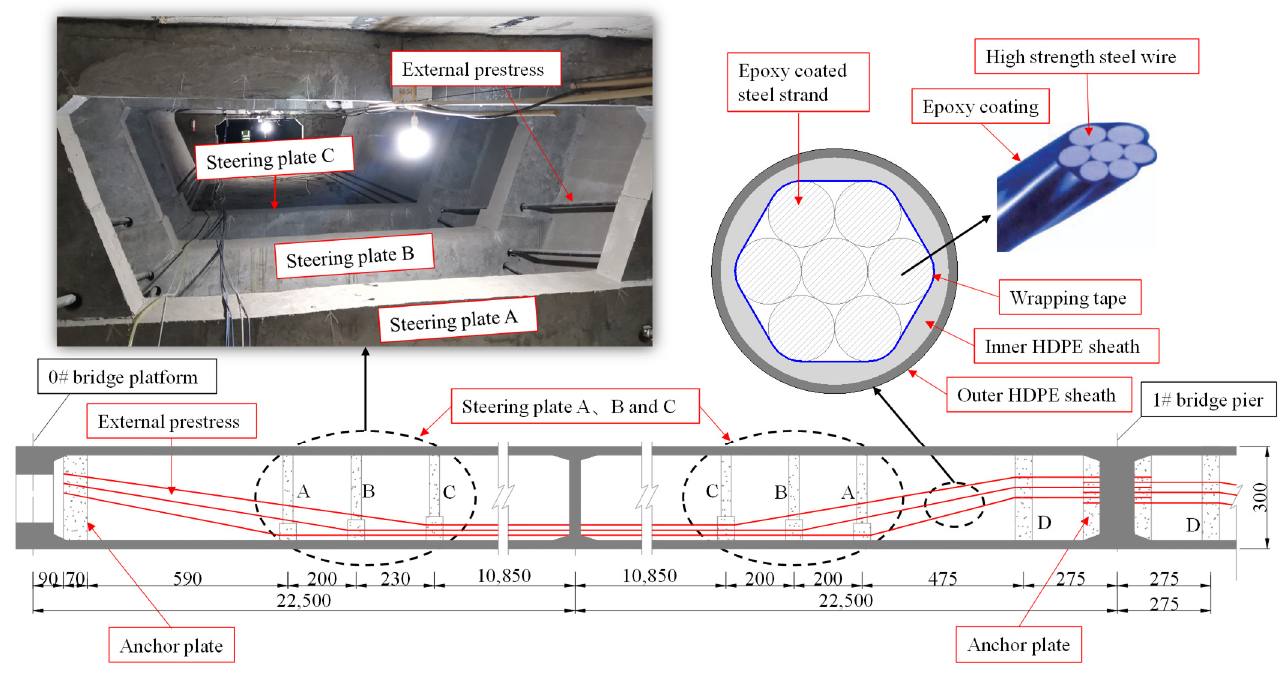
Figure 2. Diagram of the external prestressing arrangement of the first span (unit: cm).